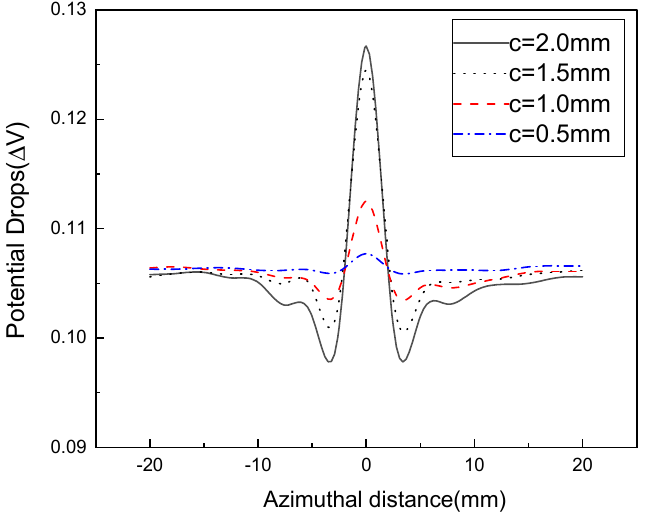
Figure 5. Variations of potential drop with different defect depths for a surface crack width of 0.5 mm.